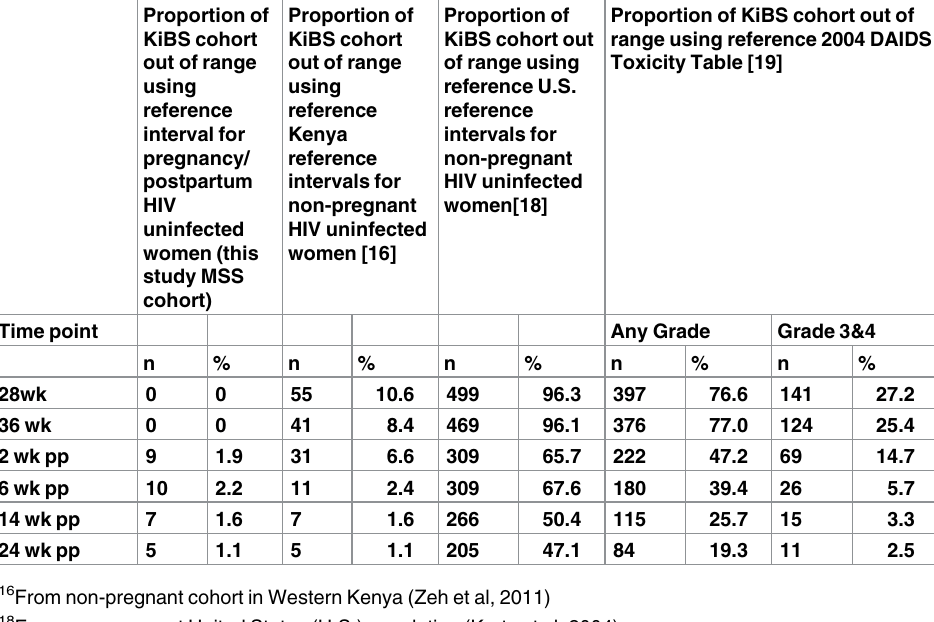
Table 2. Comparison of out-of-range values and frequency of adverseevents among HIV infected pregnant/postpartum women in the Kisumu Breastfeeding Study (KiBS) obtained from using locally- established reference intervals for pregnant and non-pregnant women in Kenya, United States refer- ence intervals and DAIDS toxicity tables. 2012–2015. Proportion of KiBS cohort out of range